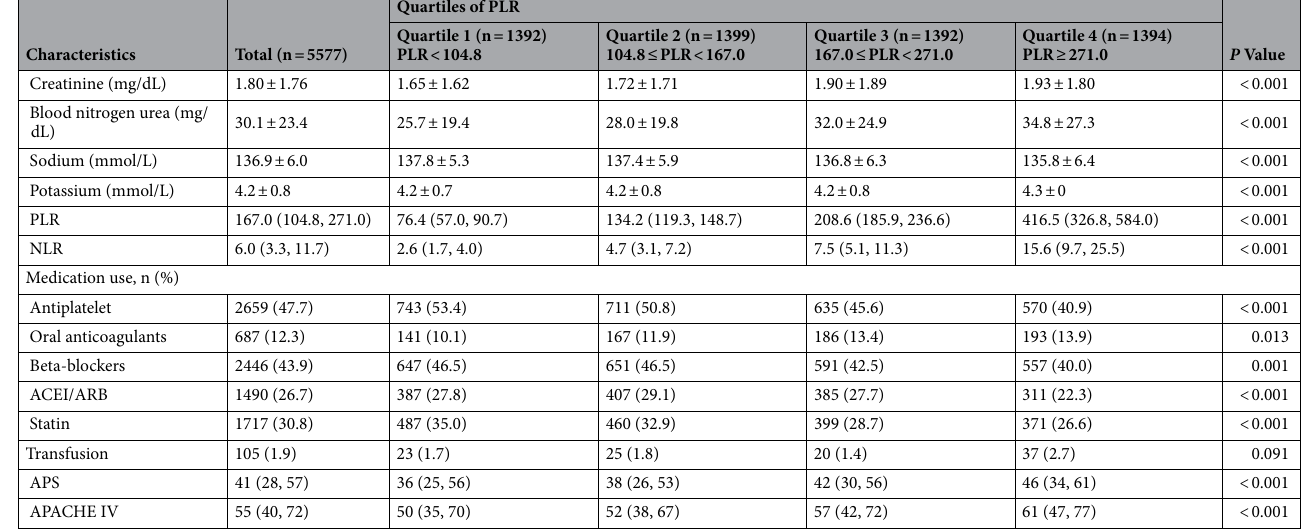
Table 1. Characteristics of patients stratified by PLR quartiles. Continuous variables were presented as mean ± SD or median (IQR). Categorical variables were presented as number (percentage). PLR platelet-